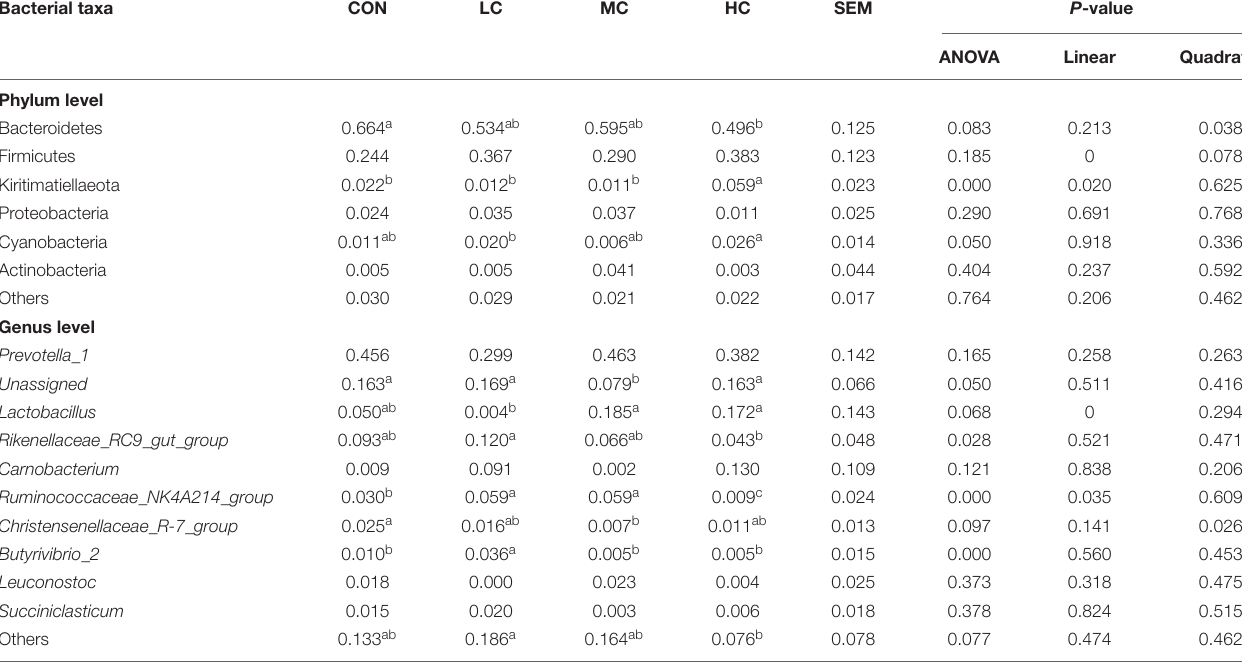
TABLE 2 | Species and relative abundance of ruminal fluid microbiota in sheep at phylum level and genus level. Bacterial